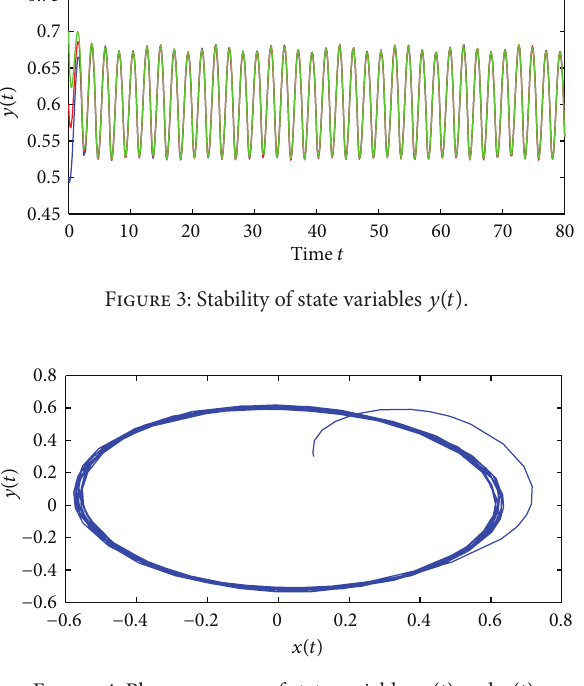
Figure 6: Phase response of state variables 𝑦(𝑡) and 𝑦 󸀠 (𝑡)